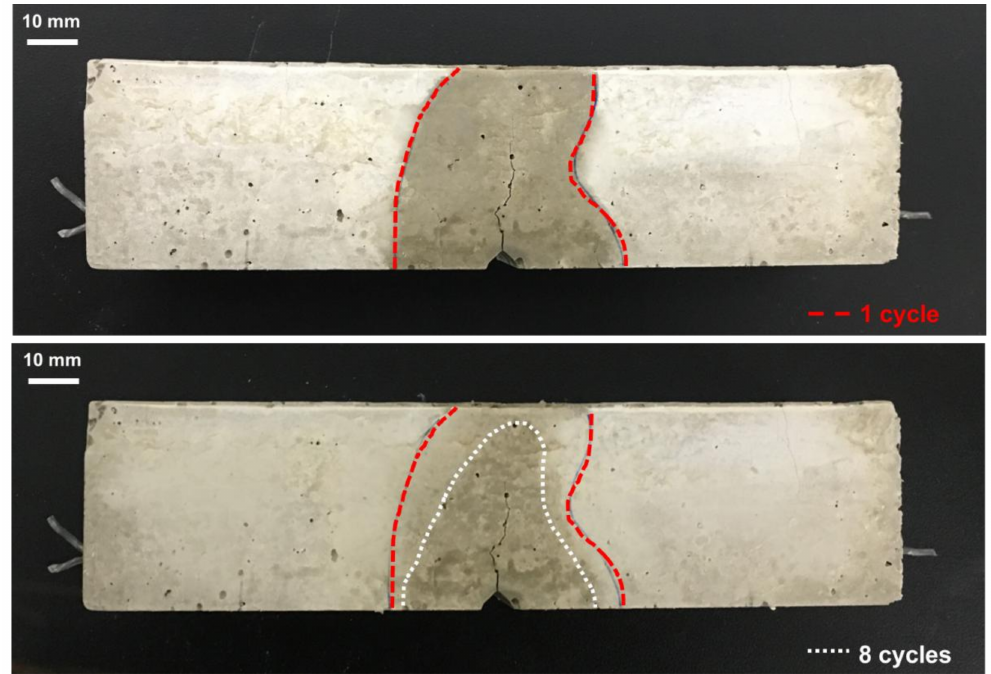
Figure 7. Region of water absorption in the S-0.5 specimen at first and eighth cycles during the capillary water absorption